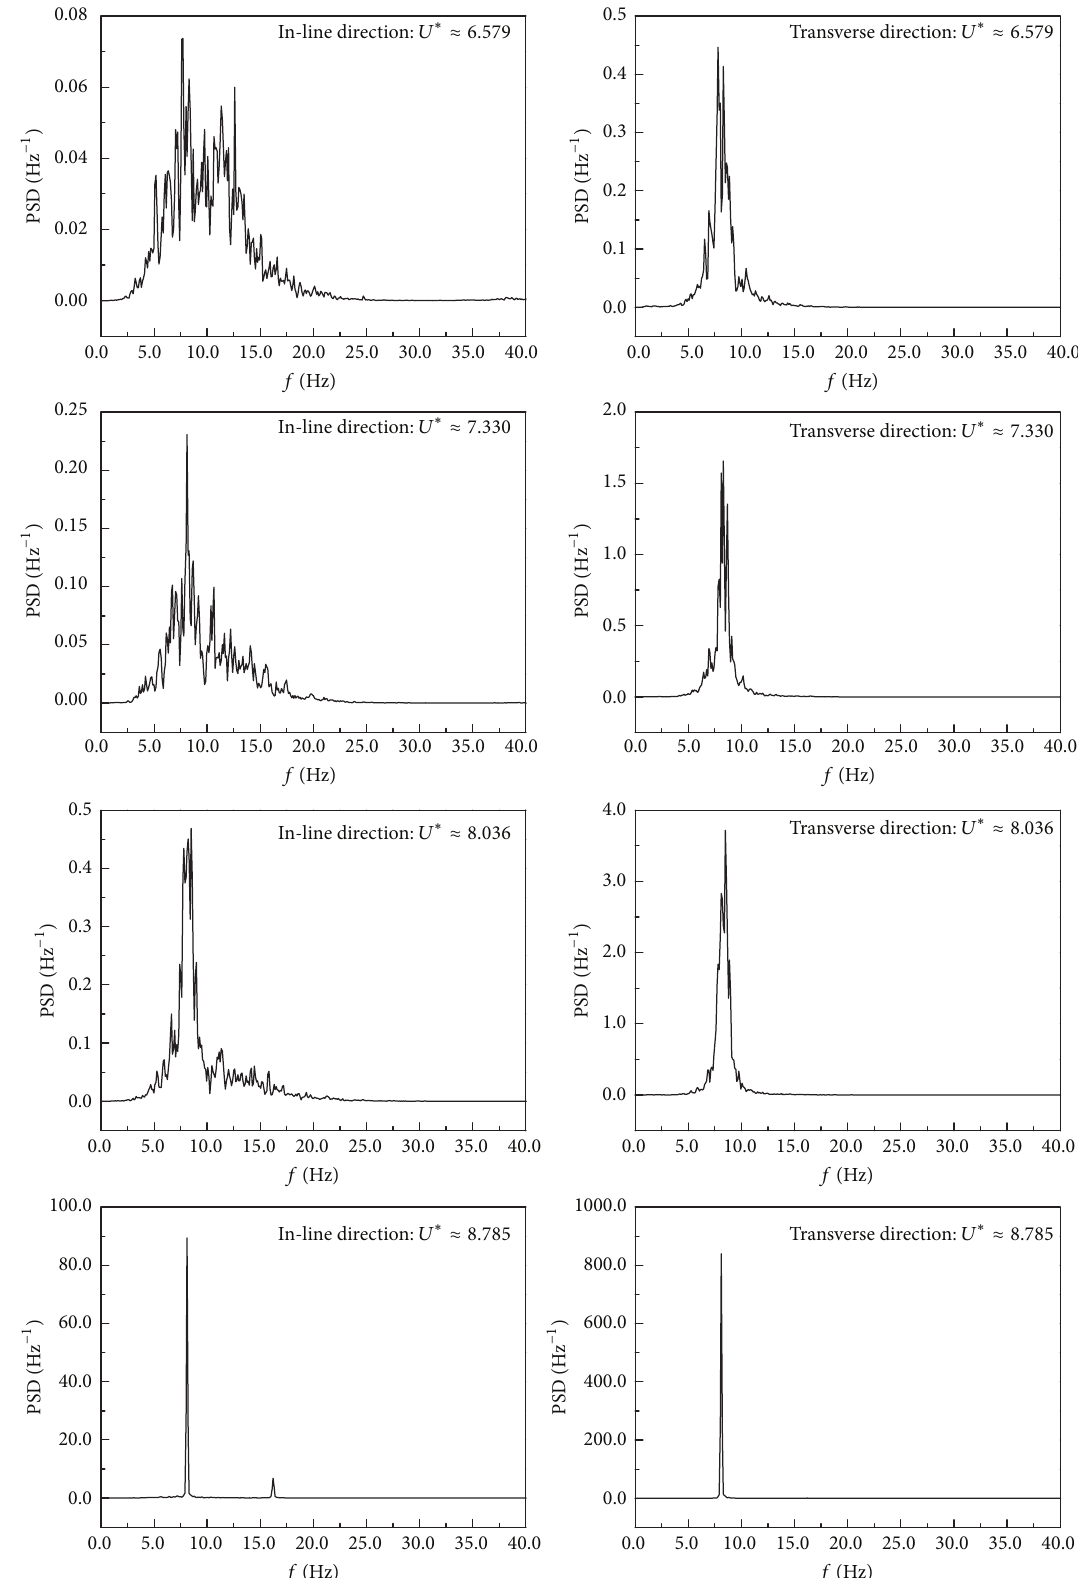
Figure 8: Power spectrum density functions of aluminum tube vibrations with the increasing of flow